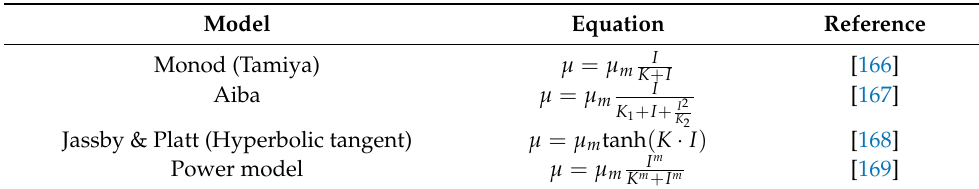
Table 3. Examples of photosynthesis-irradiance relationship